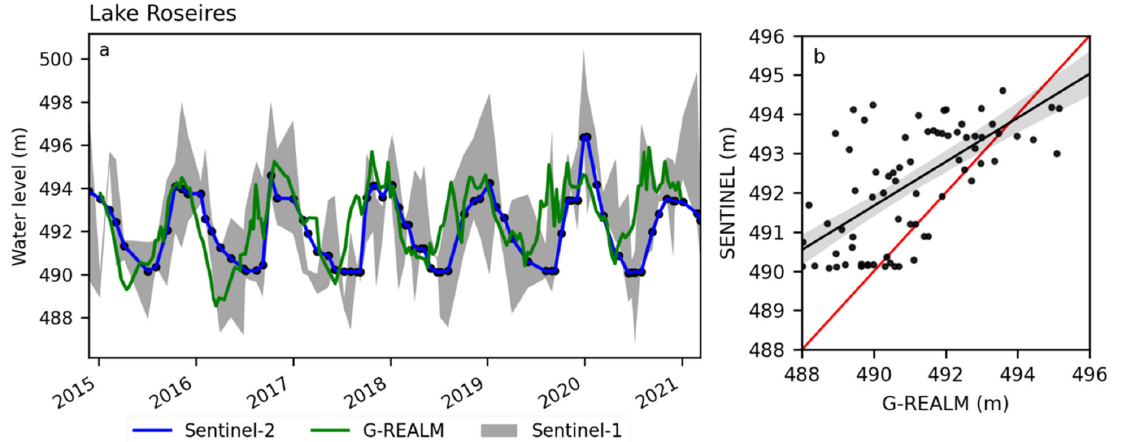
Figure 4. ( a ) Water levels estimated using contour matching from SRTM DEM with surface water extent derived from Sentinel-1, Sentinel-2, and G-REALM for Lake Roseires. The band of values for Sentinel-1 represents the water levels derived from threshold values ranging from − 15 to − 20 dB for extracting water masks. ( b ) Scatter plot showing the relationship between water levels estimated from Sentinel vs. G-REALM